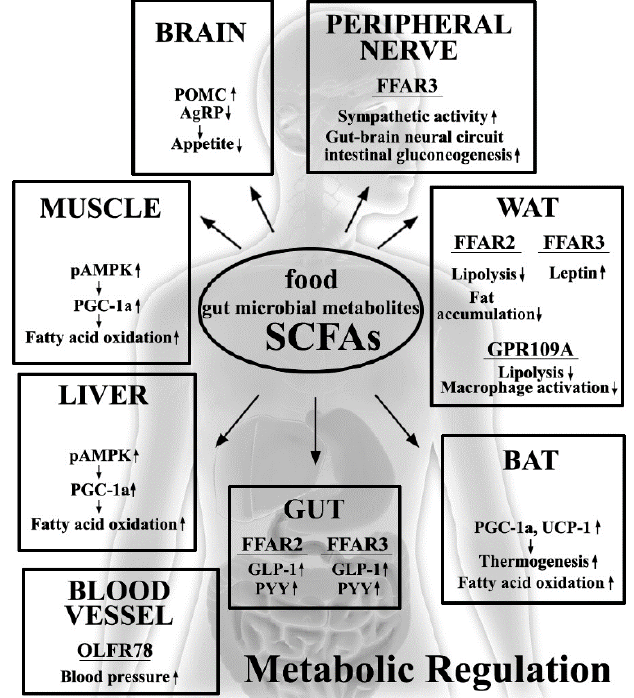
Figure 1. Effects of dietary gut microbial short-chain fatty acids (SCFAs) on the regulation of host metabolic functions. SCFAs affect host homeostasis through the stimulation of SCFA receptors, FFAR2, FFAR3, GPR109A and